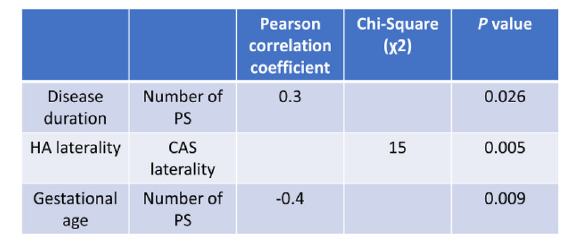
Table 1 (abstract 226). See text for